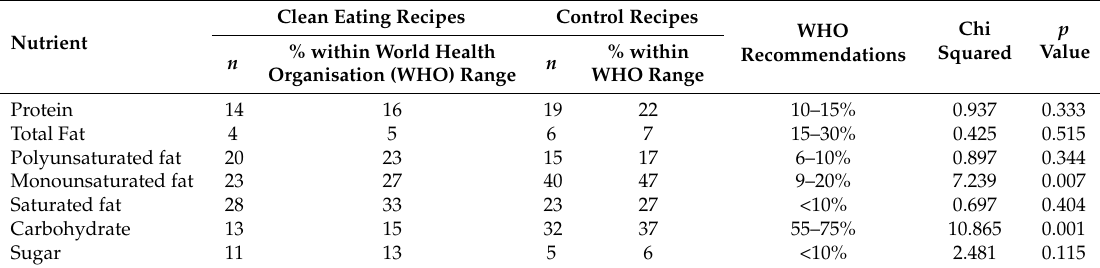
Table 3. Percentage of energy from macronutrients from clean eating recipes compared with controls.